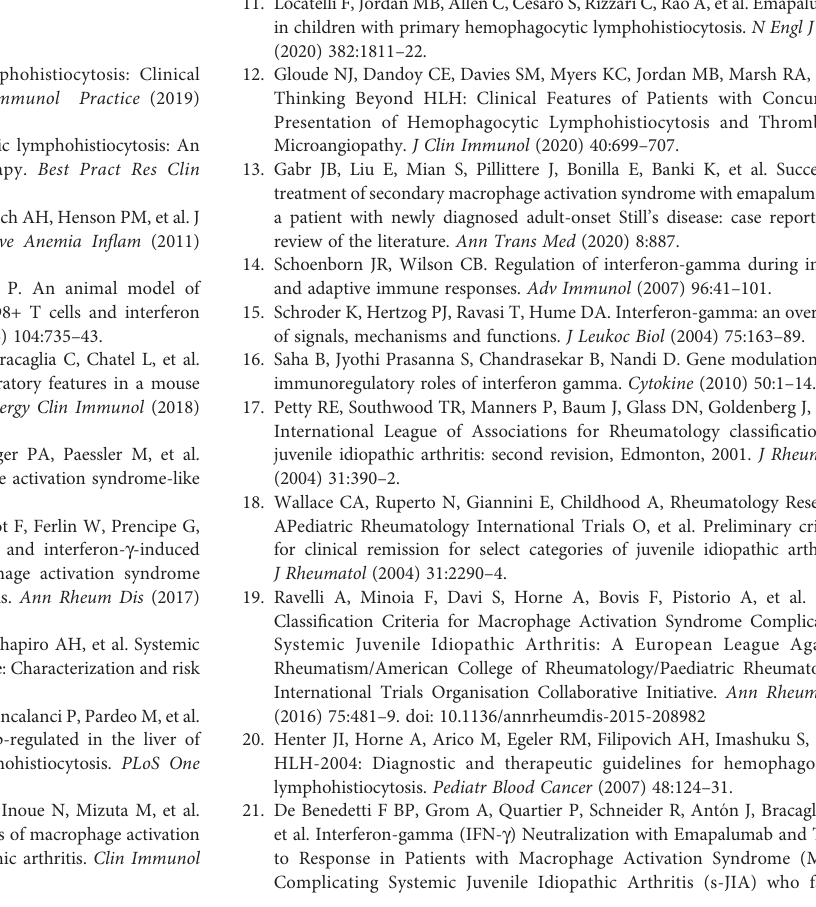
Supplementary Figure 1 | Total STAT1 levels in monocytes of sHLH/MAS patients. (A) Total STAT1 levels were evaluated in unstimulated monocytes from untreated or treated sHLH/MAS patients and compared to levels observed in monocytes from patients with other rheumatic diseases, patients with active sJIA and patients with sHLH/MAS in aremission phase. STAT1levels weremeasured by fl ow cytometry and reported as Delta mean fl uorescence intensity ( D MFI, calculated by subtracting MFI values of isotype controls from sample MFI values). Differences between groups were analyzed using the one-way ANOVA test and the post hoc Bonferroni ’ s for multiple comparisons test. The data shown represent mean (± SEM)